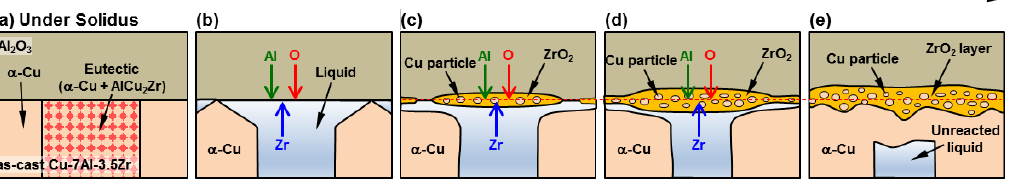
Figure 13. Schematic diagram of nucleation and growth processes of reaction layers at the Al 2 O 3 /Cu-7Al-3.5Zr alloy interface for various time periods.